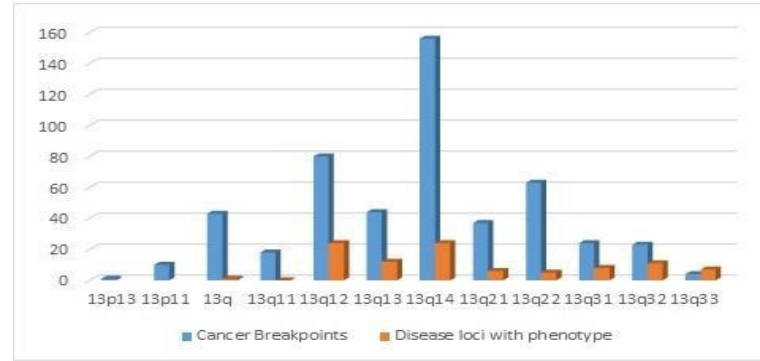
synteny in representative New World monkeys (NWM). BAC probe mapping (red and green signals) are reported on the right side of banded chromosomes. The species’ chromosome numbers are reported under the ideograms, and HSA synteny associations are on the right. Note that some species previously recognised among the Callicebus genus have now been placed among the new Plecturocebus genus in recent molecular phylogeny [103]. PA—primate ancestor, OWM — Old World monkeys. The tree topology has been here reconstructed and modified according to previous analyses and reconstructions [4,104].